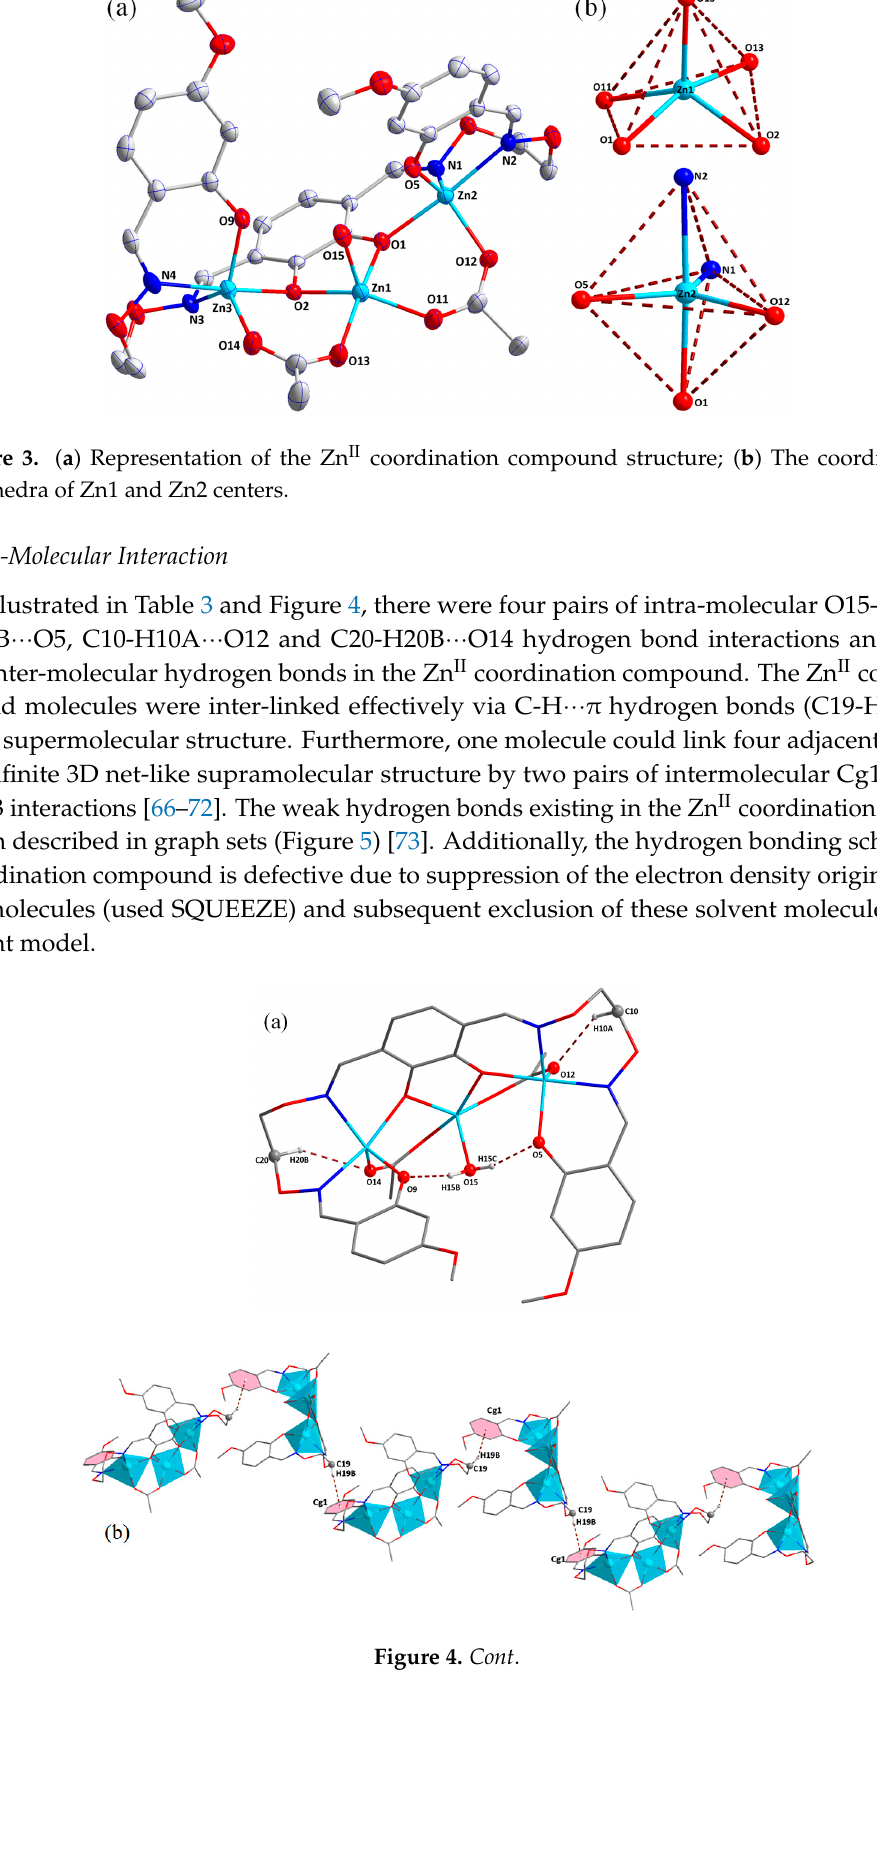
Figure 4. ( a ) Intra-molecular hydrogen bondings of the Zn II coordination compound unit (hydrogen atoms, except those forming hydrogen bonds, are omitted for clarity); ( b ) One-dimensional supra-molecular structure of the Zn II coordination compound, mediated by inter-molecular C-H ∙∙∙π (pink) interactions; ( c ) 3-D supramolecular structure of the Zn II coordination compound, mediated by intermolecular C-H ∙∙∙π and π∙∙∙π interactions.